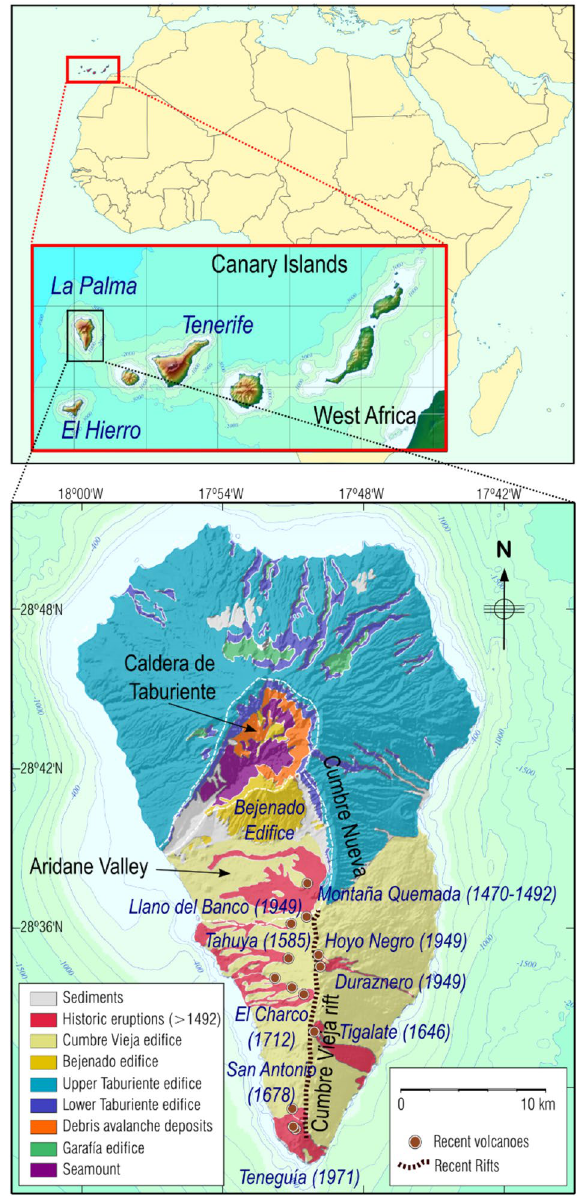
Figure 1. Geographical location and geological elements. Location of Canary Islands and La Palma Island (top panel) and simplified geological map (lower panel). See insets for scale and key. GMT software (www.gener ic-mapin g-tools .org) was used to create this